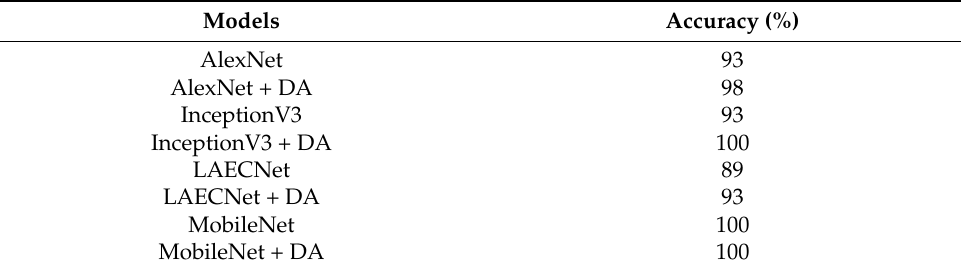
Figure 10. The classification accuracy of the proposed model. Table 4. Accuracy comparison of the proposed